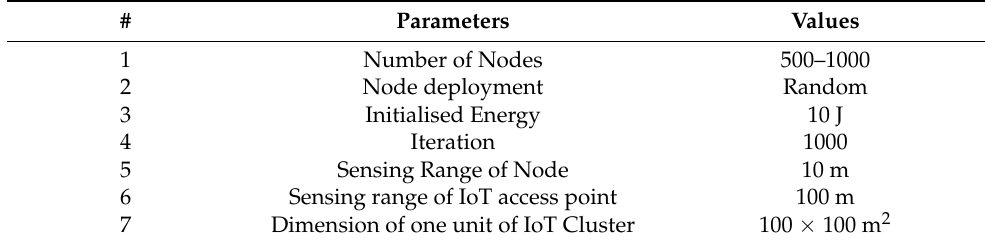
Table 1. Simulation parameters.